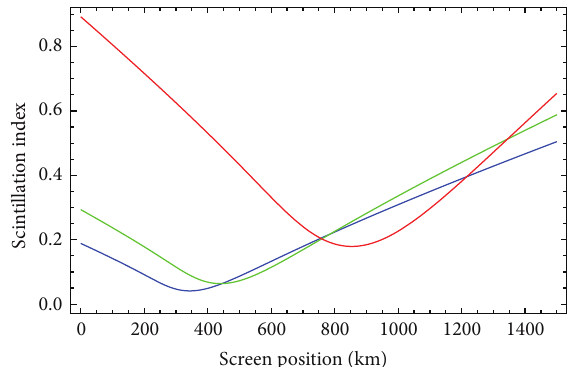
Figure 4: Virtual screen position dependencies of the scintillation index for the frequency L1 ( 𝑓 1 = 1572.42 × 10 6 Hz) for the same elevation angles as in Figure